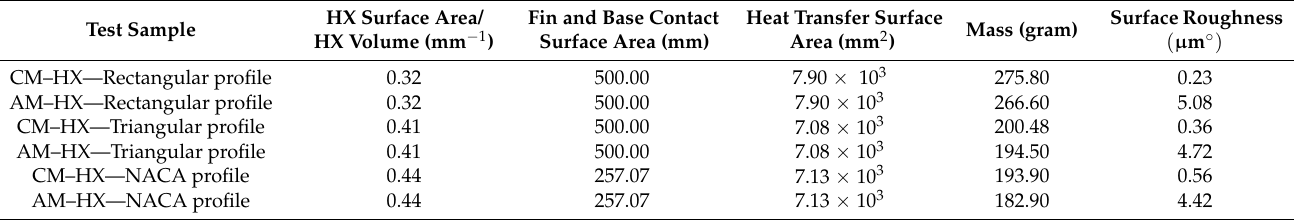
Table 2. Characteristics of test